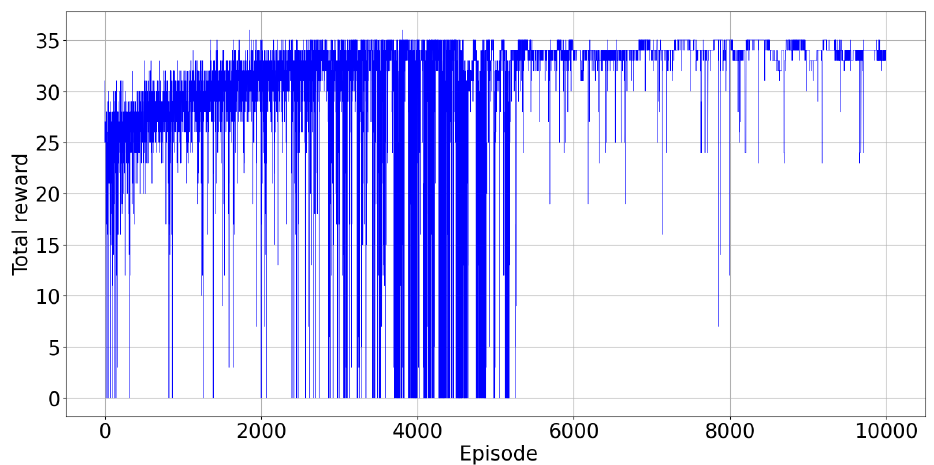
Figure 8. Scenario 2: Total observed reward at each training